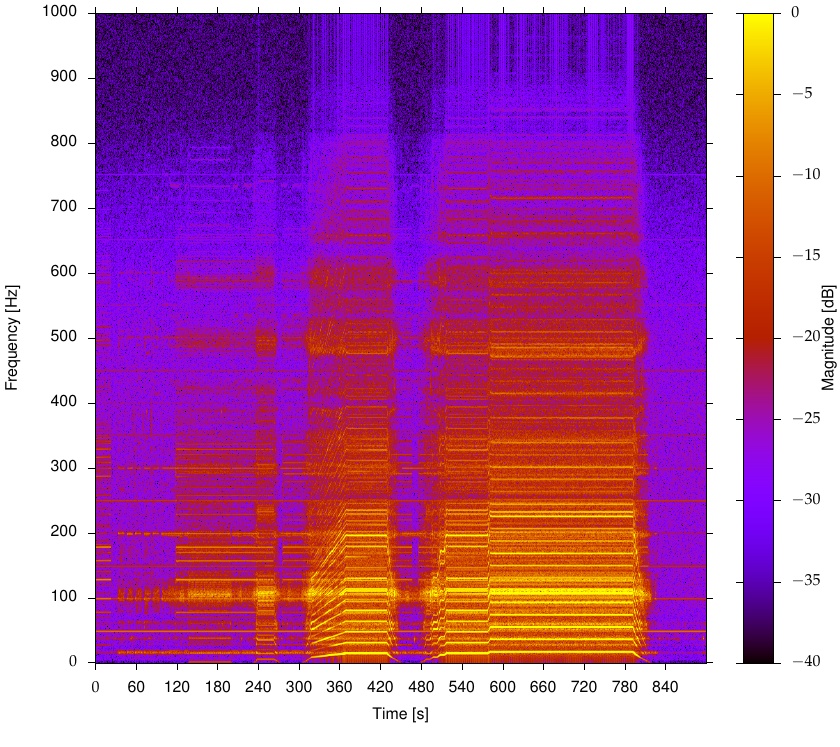
Figure 4. Spectrogram for 1200 rpm spinning cycle.